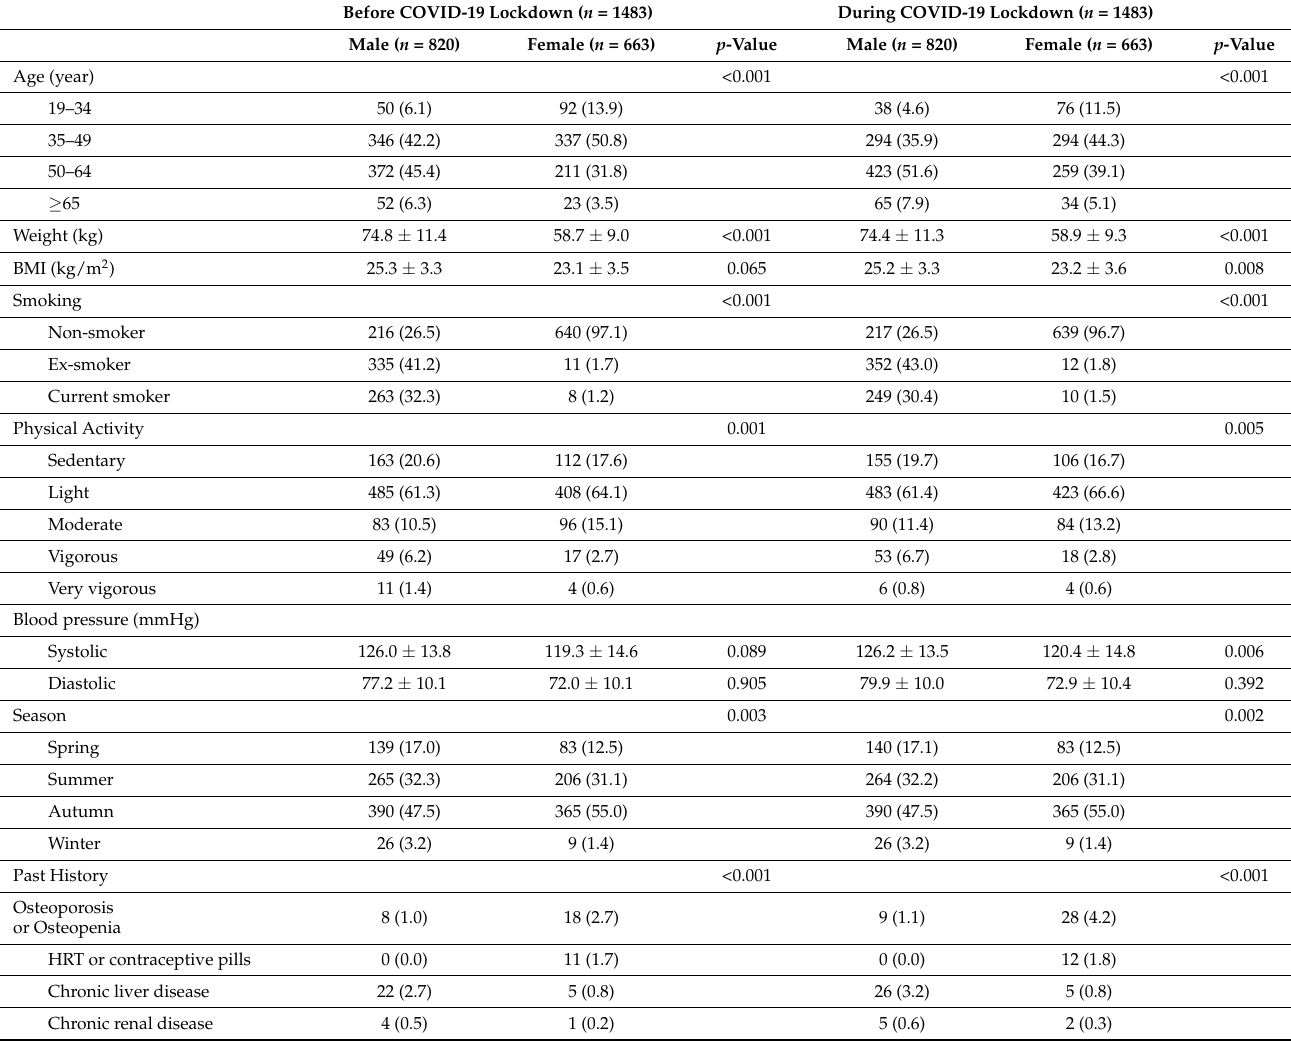
Table 1. Demographic Characteristics of